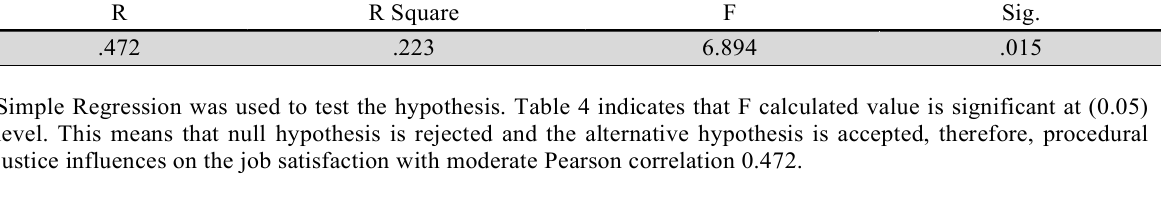
The results of testing the second sub-hypothesis R R Square F Sig. .472 .223 6.894 .015